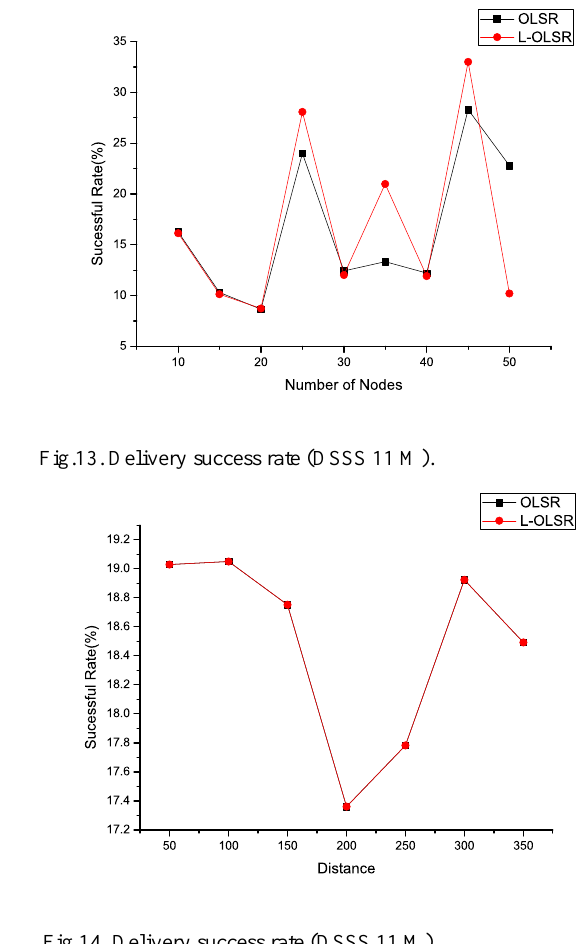
Fig.14. Delivery success rate (DSSS 11 M).